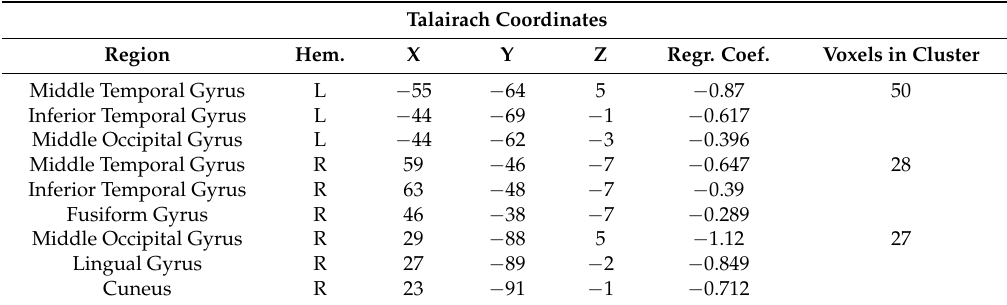
Table 5. Regions of significantly greater activity in caffeine consumers compared to caffeine non-consumers while judging the pleasantness of saccharin.